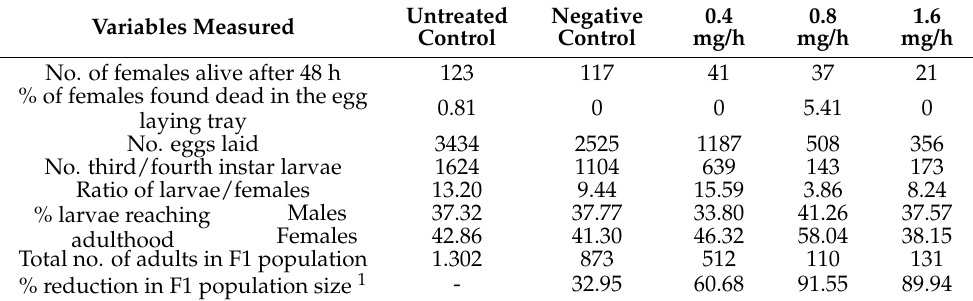
Table 6. Treatment effects on mosquito fitness and F1 population size in Ae. albopictus